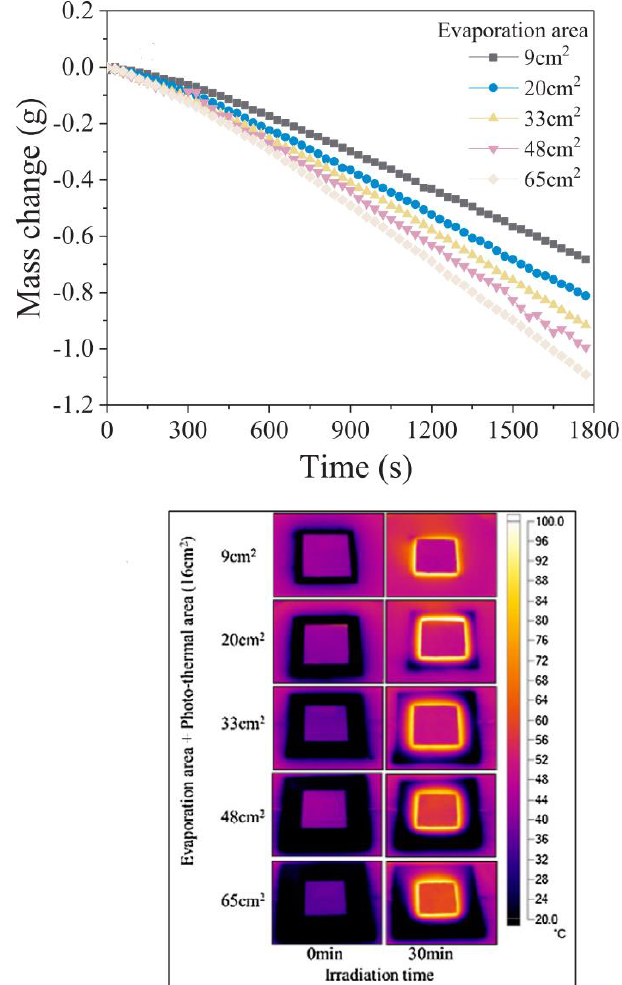
Figure 26. Experimental schematic of the C-TiO 2 solar water evaporator [94]; 2019, Elsevier.